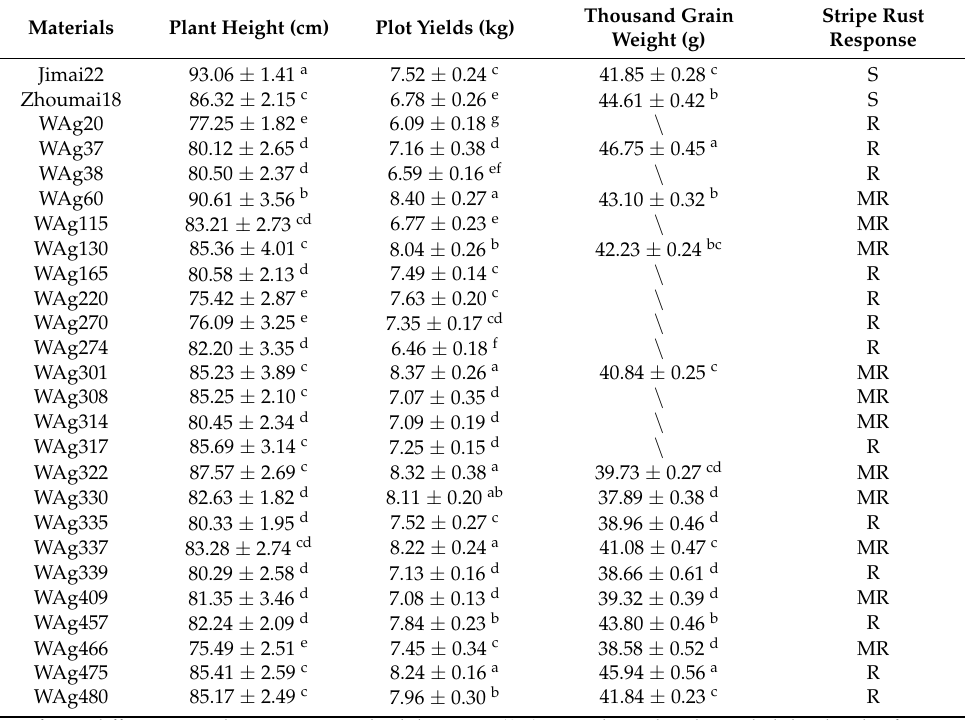
Figure 6. The detection of A . cristatum P genomic components using KASP markers and the investigation of agronomic traits of breeding lines. ( a – c ) The detection results of Agr6971kps-4, Agr4080kps-2, and Agr4080kps-4, respectively. The genotype of A . cristatum “Z559” was in red; the genotype of wheat was in blue. The genotype of the breeding lines was in the circles. ( d , e ) The agronomic traits of partial breeding lines including resistance to stripe rust and other agronomic traits in the field. Table 2. The agronomic traits of wheat– A . cristatum breeding lines in